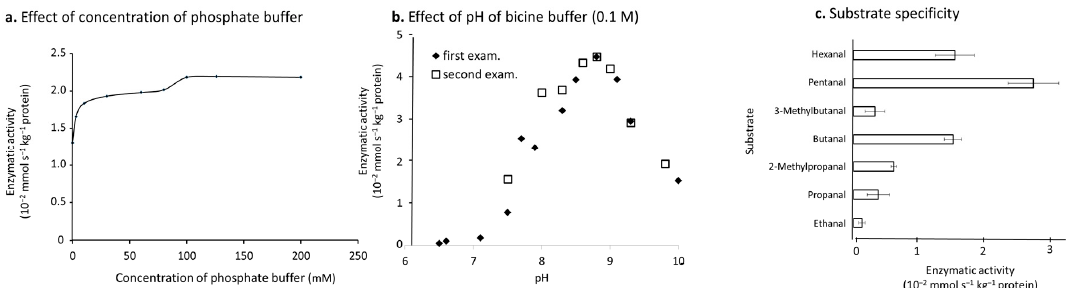
Figure 6. Activity of crude ALDH. ( a ) Optimum concentration of phosphate buffer; ( b ) Optimum pH; and ( c ) Substrate specificity to C2–C6 branched and straight chain aldehydes. Horizontal line at each column shows average ± SD (n = 3).